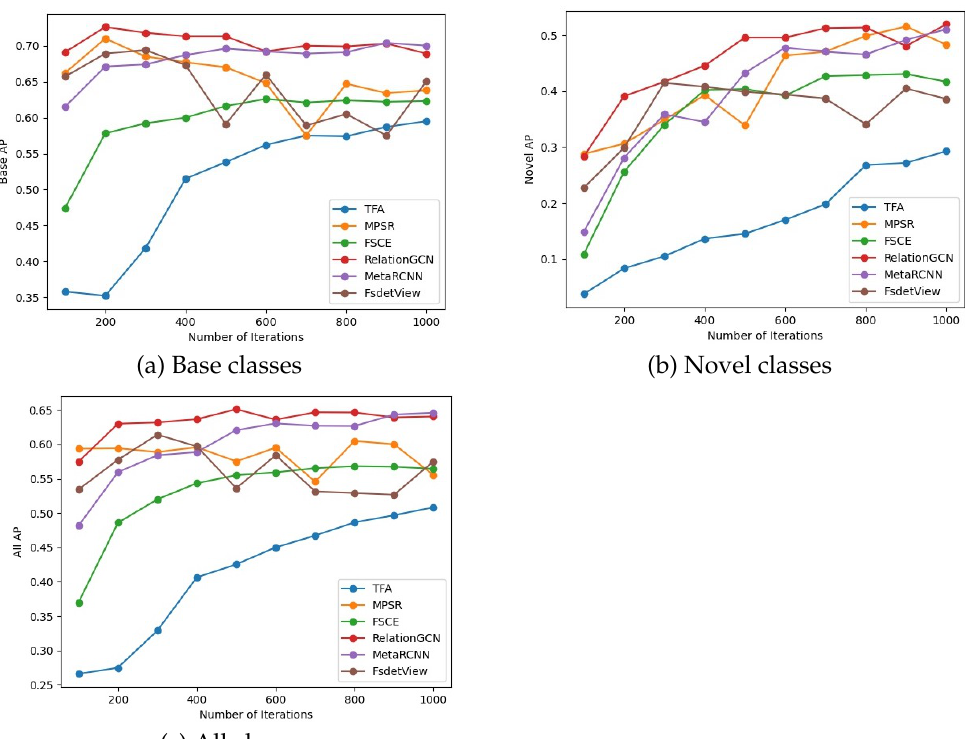
Figure 12. Comparison of few-shot fine-tuning speed of different methods on three types of classes under 10-shot